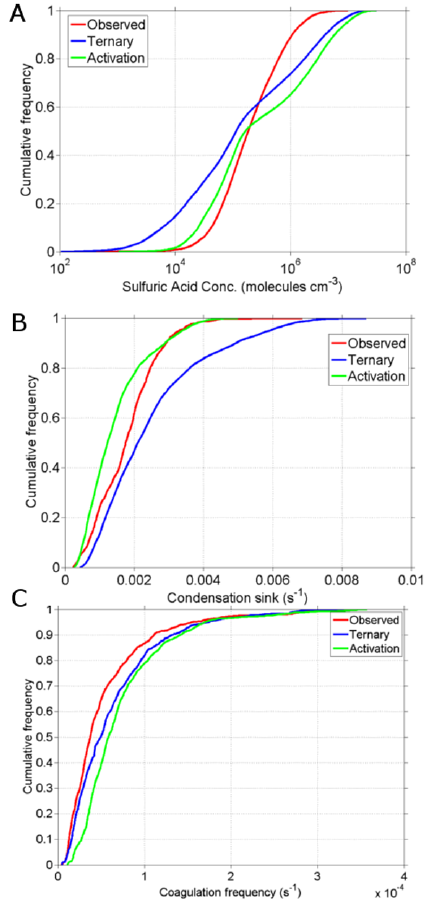
Fig. 10. Additional nucleation metrics at Hyyti¨al¨a for the ternary (with 10 − 5 tuning factor) and activation models and the measure- ments. (A) shows the CDF of the maximum daily sulfuric acid con- centration. (B) is a CDF of modeled and measured condensation sink values. (C) shows the CDF of coagulation sink for 3nm parti- cles.